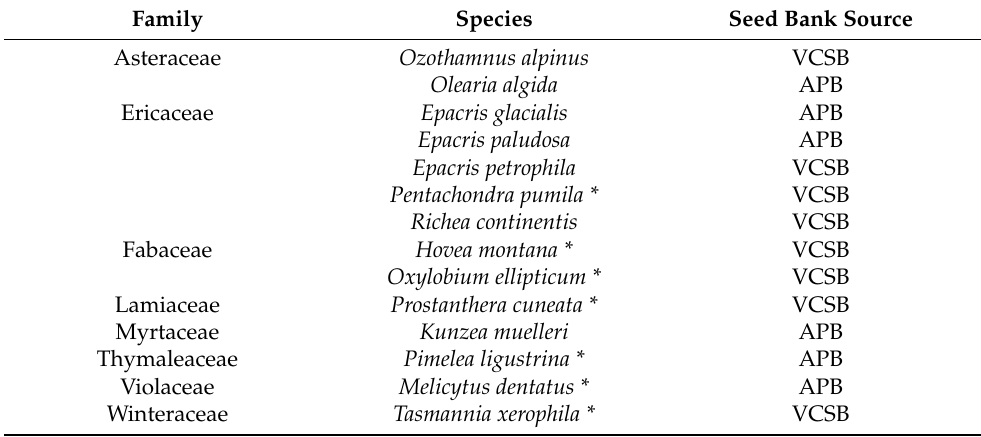
Table 1. The families, species and their seed bank source used in this study. Species marked with an asterisk* failed to germinate sufficiently to be included in further data analysis. VCSB denotes Victorian Conservation Seed Bank, Royal Botanic Gardens Victoria, APB denotes Australian PlantBank, Australian Botanic Garden Mount Annan. Family Species Seed Bank Source Asteraceae Ozothamnus alpinus VCSB Olearia algida APB Ericaceae Epacris glacialis